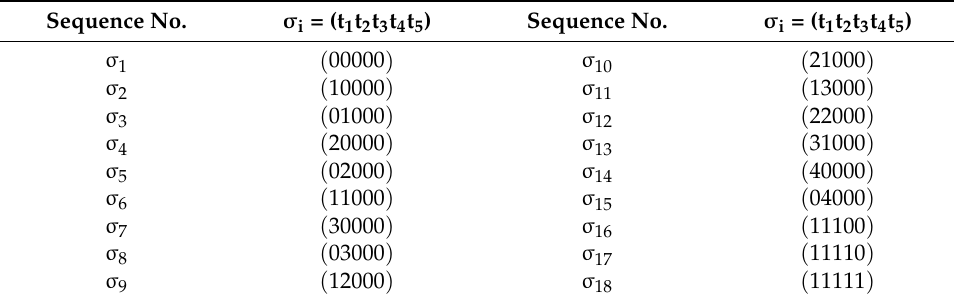
Table 5. Usable sequences of Example